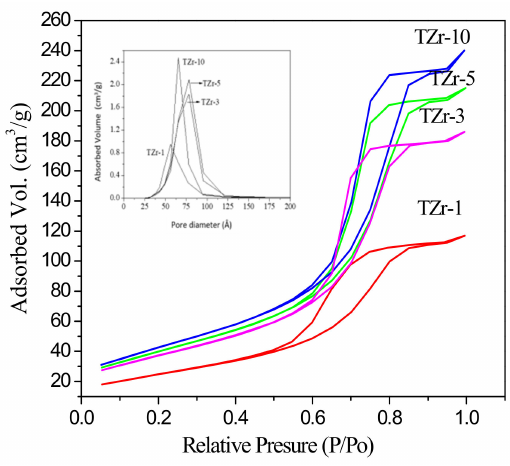
Figure 2. N 2 adsorption-desorption isotherms of the Ti–Zr